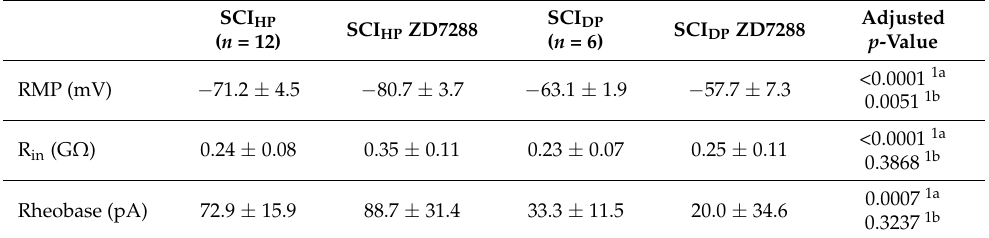
Table 3. Effects of ZD7288 on two groups of axotomized M1LV neurons after